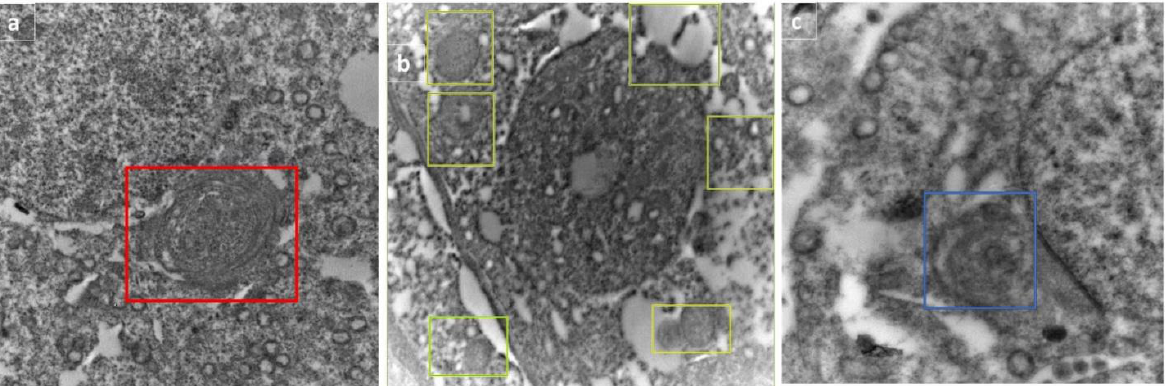
Figure 11. Selected micrographs of rats treated with RFX for two weeks after exposure to malathion show the assembly and progression of autophagic vesicles, indicating active autophagy flux in form of autophagosome (represented by box) ( a ), autophagosome – lysosome fusion (shown in boxes) ( b ), and autolysosome (shown in box) ( c ).